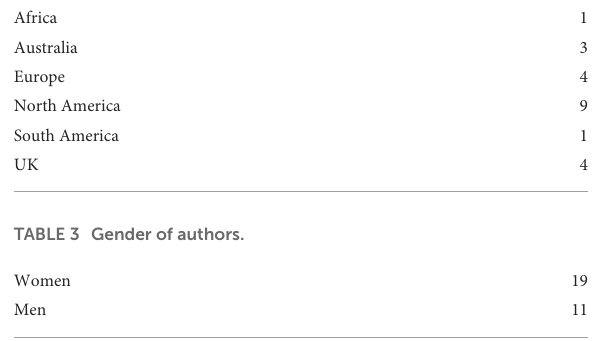
Figure 1 below is a flowchart of the screening